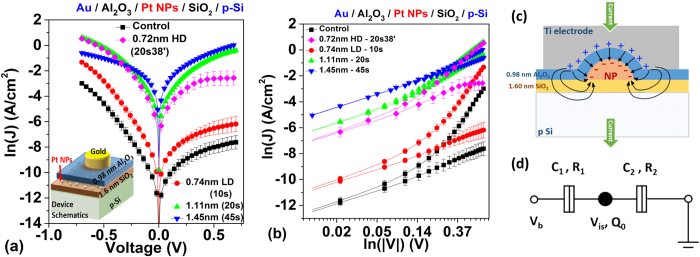
Comparison of Au/p-Si contact with different size of Pt NPs sandwich between the 0.98 nm Al2O3 and 1.6 nm SiO2 (a) Ln(J)-V characteristics. Inset: Schematics of device structures; (b) Ln(J)- Ln(|V|) characteristics; (c) schematics showing the dipole formation between Ti or Au electrode and Pt NP; (d) Equivalent circuit of the device showing the Coulomb blockade effect.